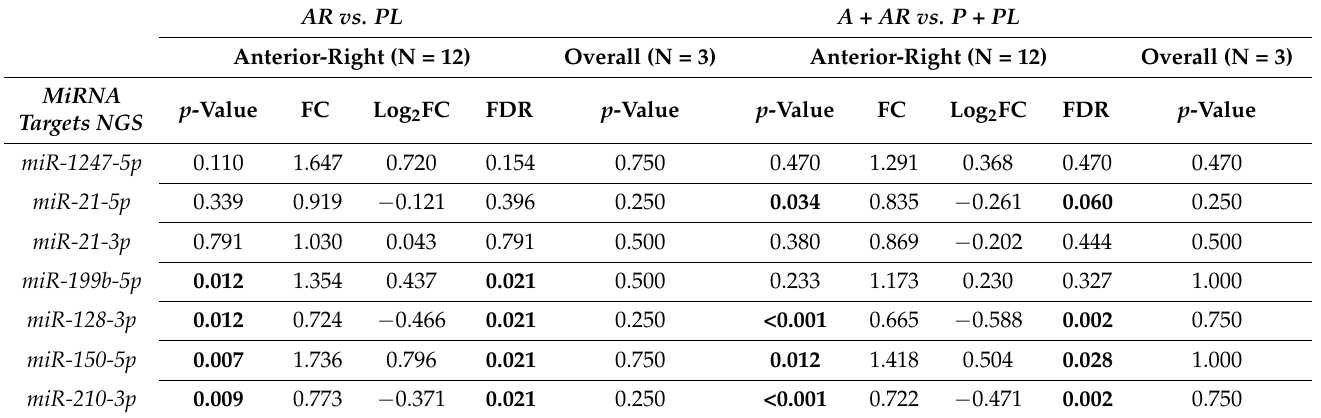
Table 3. miRCURY LNA validated targets from segmental